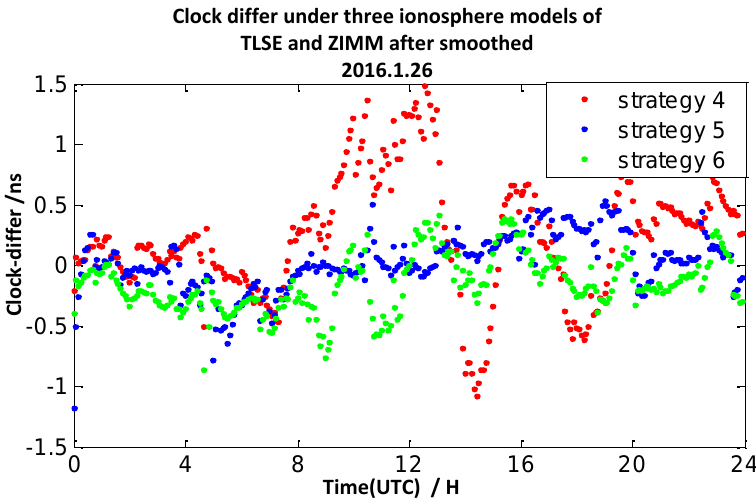
Figure 18. The clock di ff erence under three ionosphere models of TLSE and ZIMM after being smoothed. Sensors 2020 , 20 , x FOR PEER REVIEW Figure 18. The clock difference under three ionosphere models of TLSE and ZIMM after being smoothed. Figure 18. The clock difference under three ionosphere models of TLSE and ZIMM after being smoothed.